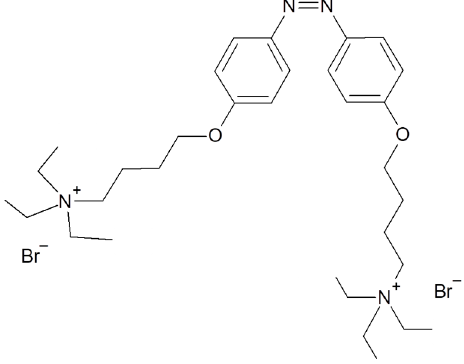
Figure 33. Schematic structure of compound Azo 1 [178].